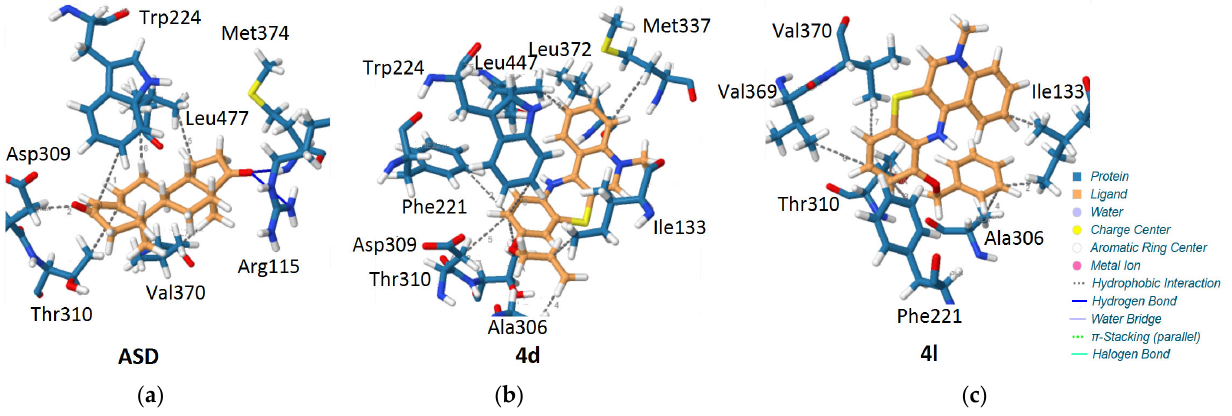
Figure 2. Spatial comparison of binding interactions for ASD ( a ) and the most potent inhibitors, 9 ‐ allyloxy derivative 4d ( b ) and 11 ‐ benzyloxy derivative 4l ( c ), generated by the PLIP tool.